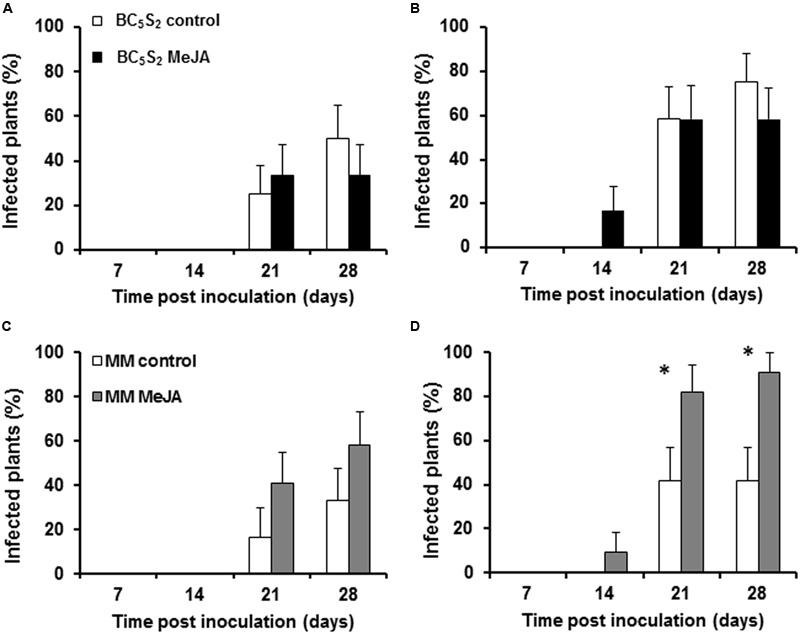
Effect of Methyl jasmonate (MeJA) applications (on days 0, 7, and 14) on TYLCD incidence in MM and BC5S2 plants. TYLCV-IL agroinoculation was performed at 21 days after initial MeJA treatment. Percentage (mean + SEM) (n = 12) of infection at several time points after TYLCV-IL agroinoculation of mock-treated and multiple MeJA-treated BC5S2
(A,B) and MM (C,D) plants is shown. The experiment was repeated twice, in February (A–C) and May (B,D). Number of infected vs. non-infected plants were analyzed by Generalized Linear Models using Logit as the link function and Binomial as the probability distribution. Asterisks indicate significant differences between treatments (P < 0.05) for each time point.